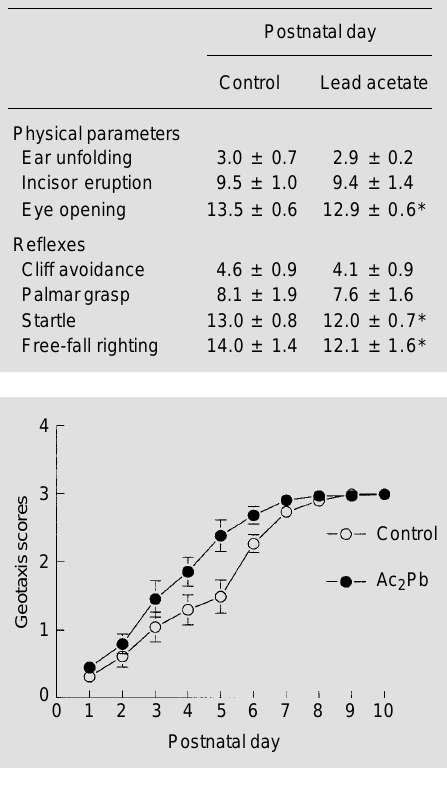
Table 2 - Postnatal day of appearance of some physical parameters and reflexes. Palmar grasp is scored as the postnatal day of disappearance of the reflex. Data are reported as mean litter scores (± SEM) of 11 control and 9 Ac 2 Pb litters. *P<0.05 compared to respective control (F values are presented in Results).